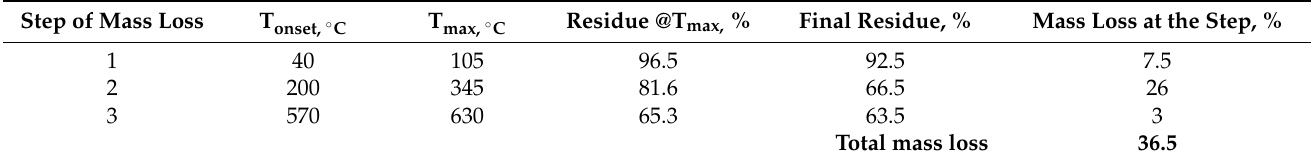
Table 1. Description of significant temperatures from TG and DTG curves.